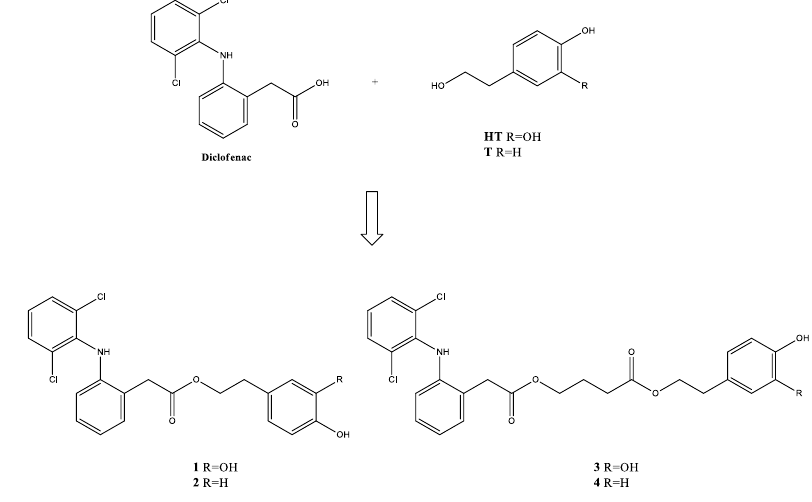
Figure 1. Chemical structure of synthesized hybrids ( 1 – 4 ).